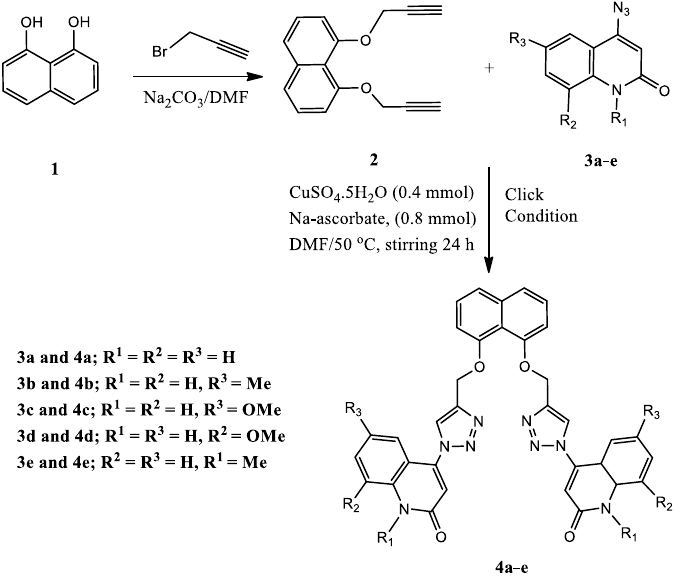
four cancer cell lines: A549 (epithelial cancer cell line), MCF-7 (breast cancer cell line), Panc-1 (pancreas cancer cell line), and HT-29 (colon cancer cell line). The most effective